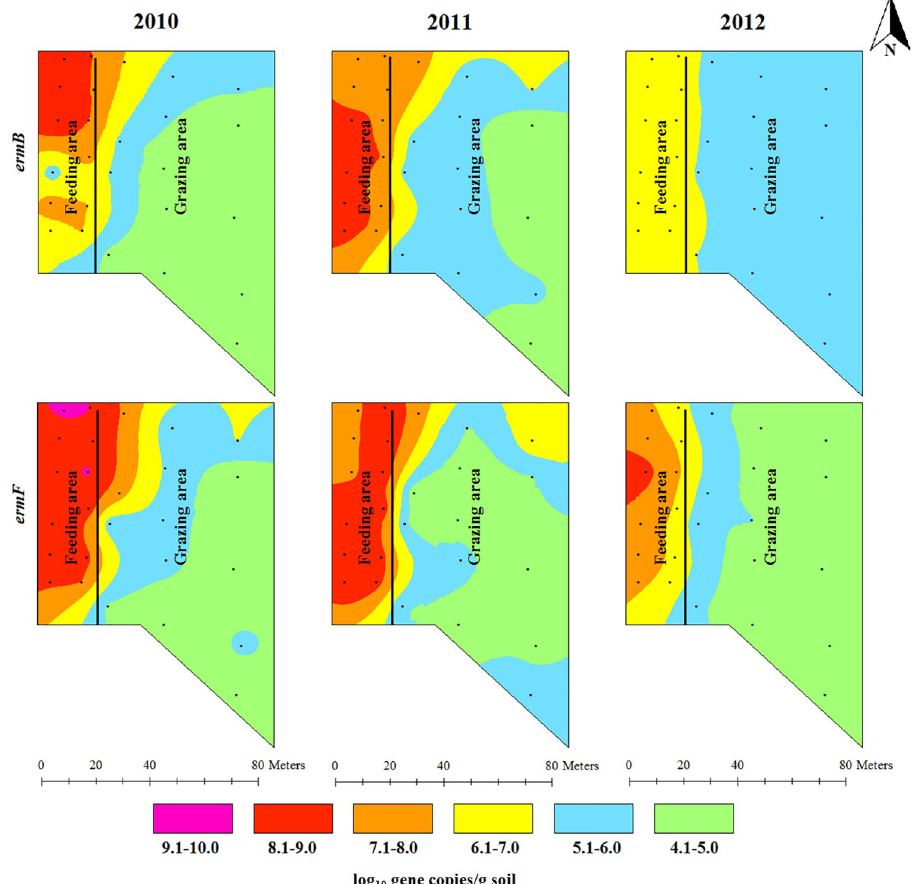
Fig 3. Spatial distributions of erythromycin resistance gene ( erm B and erm F) concentrations in beef cattle backgrounding environment over a period of two years after cattle removal.